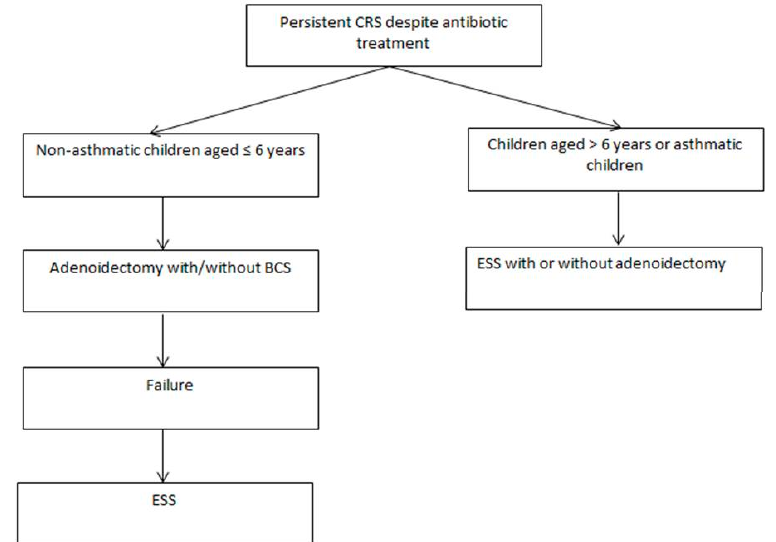
Figure 2. Protocol treatment. CR = chronic rhinosinusitis; BCS = balloon catheter sinuplasty; ESS = endoscopic sinus surgery.